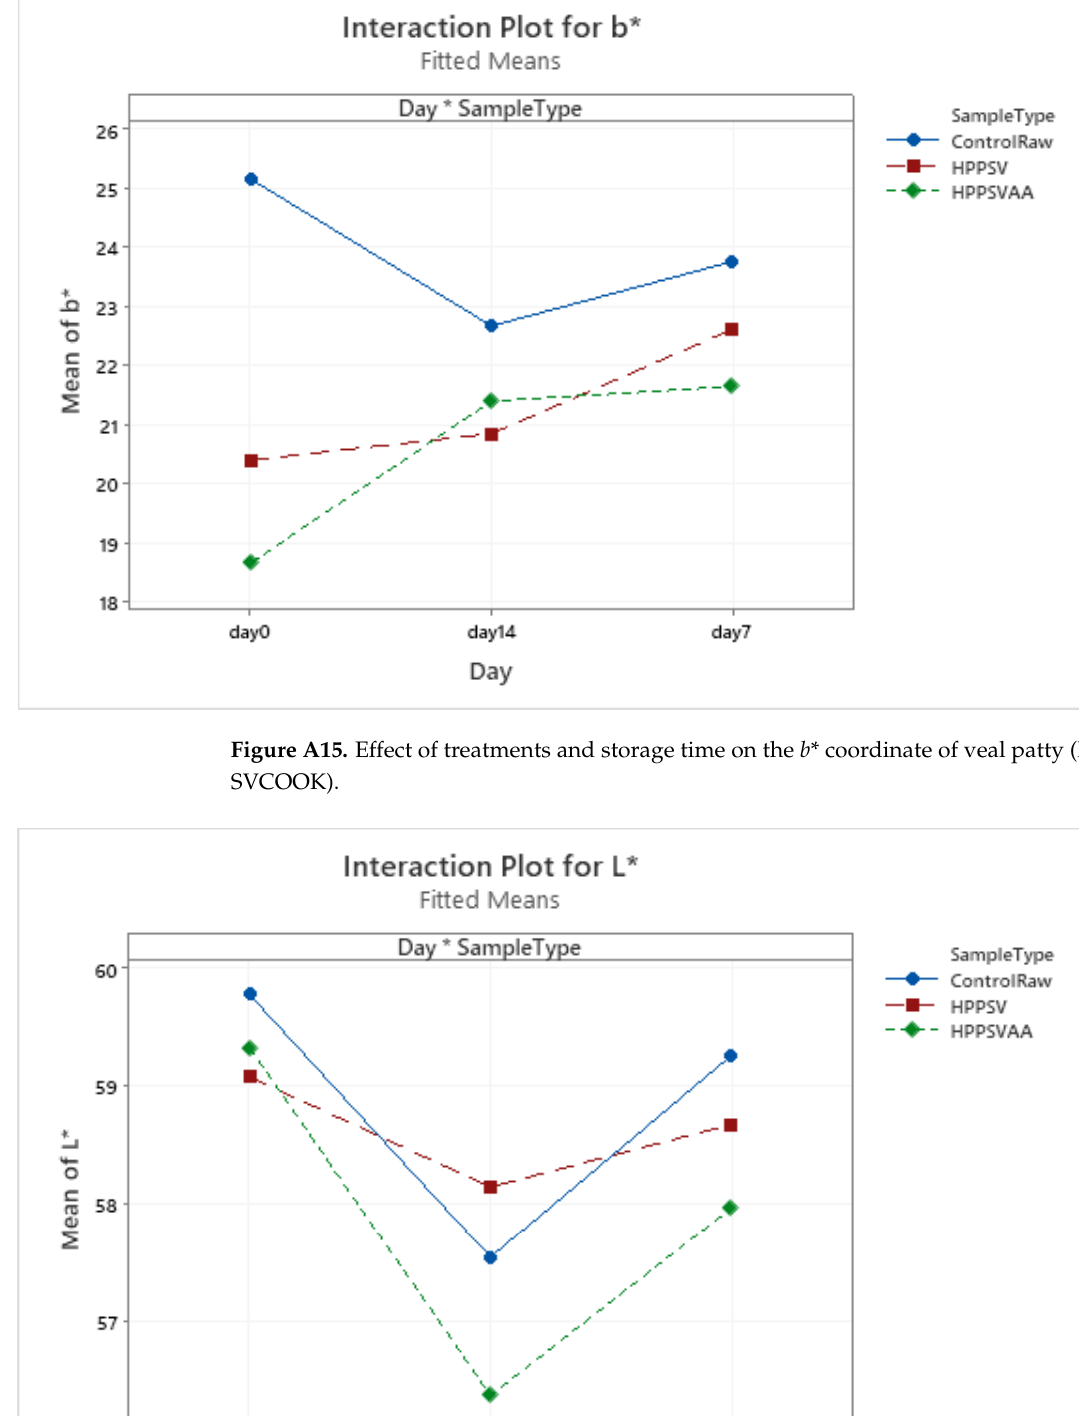
Figure A14. Effect of treatments and storage time on the a * coordinate of veal patty (HPPSV: HPP- SVCOOK).